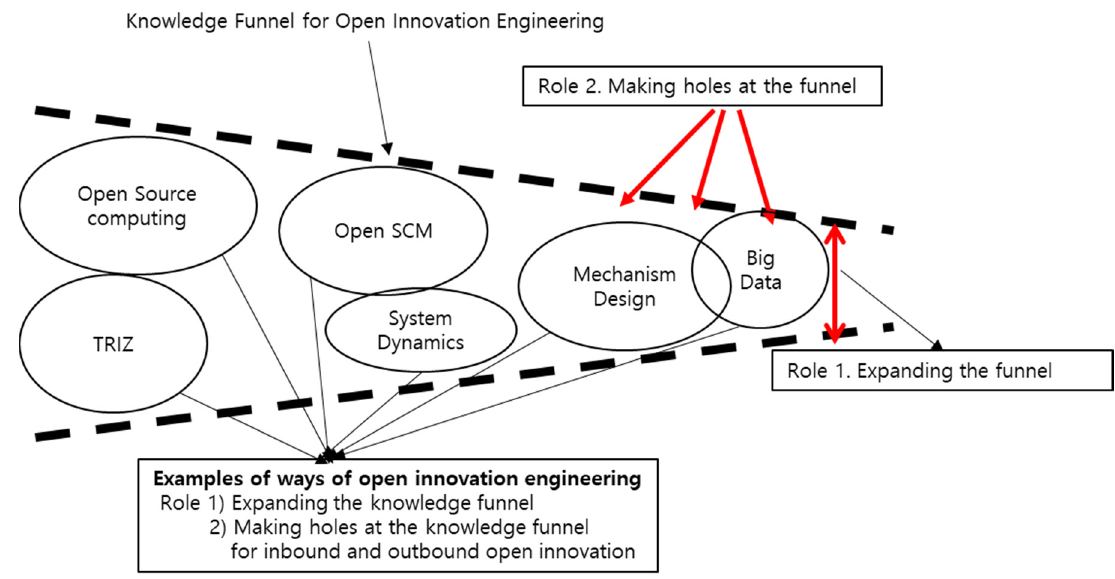
Figure 1. Open innovation engineering at the knowledge funnel.